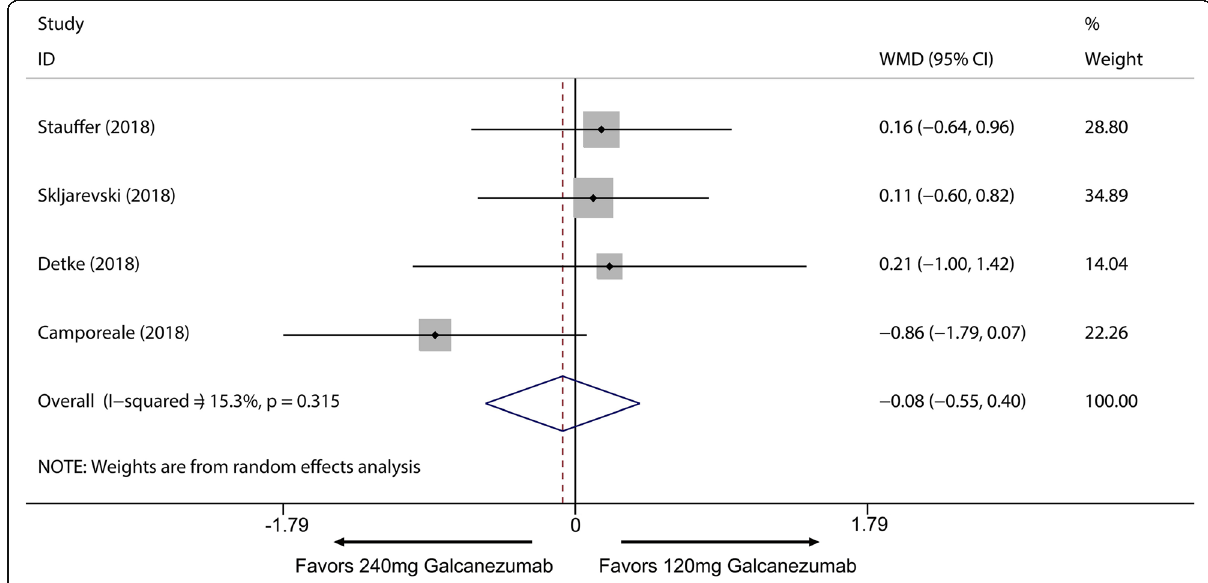
Fig. 6 Comparison of MHDs reduction between 120 mg and 240 mg galcanezumab. WMD weighted mean